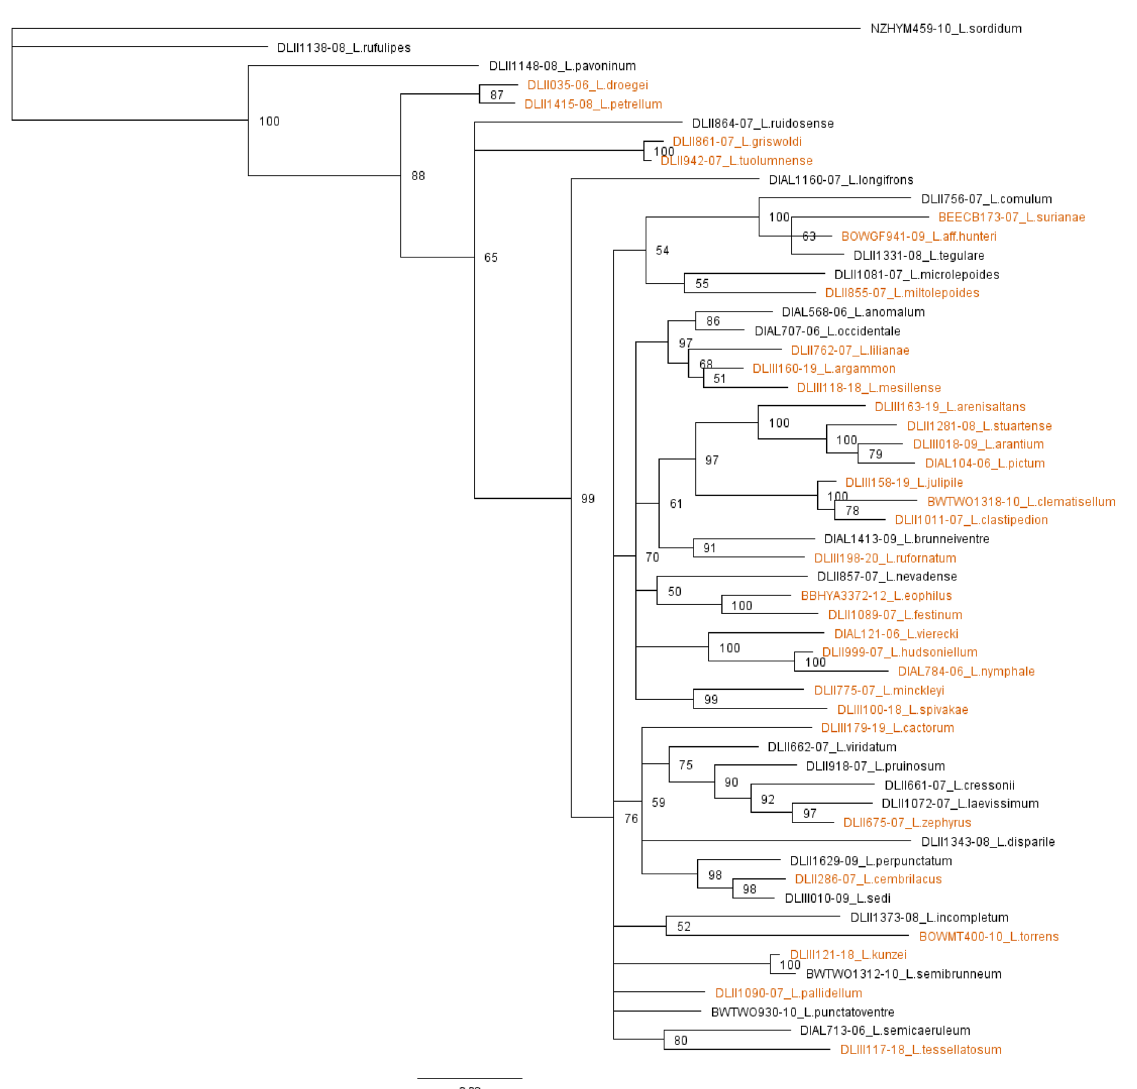
Fig. 7. 50% majority-rule consensus tree of red-tailed Lasioglossum ( Dialictus ) and representatives of other major lineages of L. ( D. ) based on a Bayesian phylogenetic analysis of 654-bp CO1 barcode sequences downloaded from BOLD. MCMC tree search was run in MrBayes ver. 3.2.7 for 30 000 000 generations, using a GTR+I+Γ model of evolution, with L. ( Austrevylaeus ) sordidum (Smith, 1853) set as the outgroup. Node labels are posterior probabilities. Names in vermilion text are red-tailed species; BOLD process IDs are given before species names. In addition to the labeled red-tailed species, L. ( D. ) rufulipes (Cockerell, 1938) is hypothesized to be an additional lineage containing the red-tailed species L. ( D. ) testaceum (Robertson, 1897), for which CO1 barcodes were not available. As this phylogeny is based on very limited data, some relationships are likely misleading or incorrect (particularly those with low posterior probability); however, it serves to illustrate the point that the red- tailed L. ( Dialictus ) are an unnatural